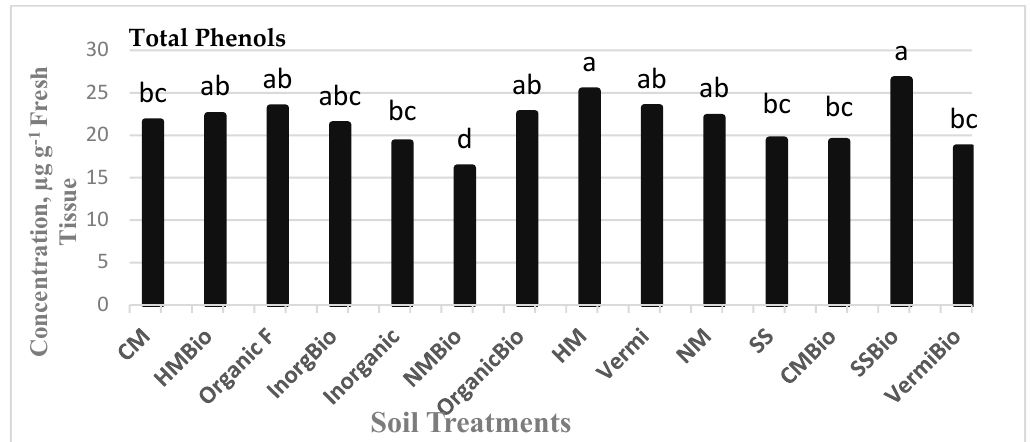
Figure 4. Concentrations of total phenols in tomato grown in soils amended with: Vermicompost (Vermi), no ‐ mulch soil mixed with biochar (NMBio), inorganic fertilizer (Inorganic), sewage sludge mixed with biochar (SSBio), vermicompost mixed with biochar (VermiBio), inorganic fertilizer mixed with biochar (InorganicBio), chicken manure mixed with biochar (CMBio), horse manure mixed with biochar (HMBio), chicken manure (CM), horse manure (HM), organic fertilizer mixed with biochar (OrganicBio), sewage sludge (SS), no ‐ mulch bare soil (NM), and organic fertilizer (Organic). Values accompanied by the same letter(s) are not significantly different ( p > 0.05). Soluble sugars concentration was greatest in fruits that were collected from plants grown in SS amended soil as compared to all other amendments (Figure 5). Chemical analysis of mature tomato fruits revealed that fruits of plants grown in SS amended soil contained the greatest concentration of NO − 3 (17.2 μ g g − 1 fresh fruits), whereas the fruits of plants grown in SS biochar amended soil contained the lowest concentrations of nitrate (5.6 μ g g − 1 fresh fruits), as shown in Figure 6, indicating the role of biochar in reducing NO − 3 in SS amended soils. Overall, the NO − 3 concentrations in tomato fruits were highly significant ( p < 0.001) among the seven amendments used in this investigation (Table 2).